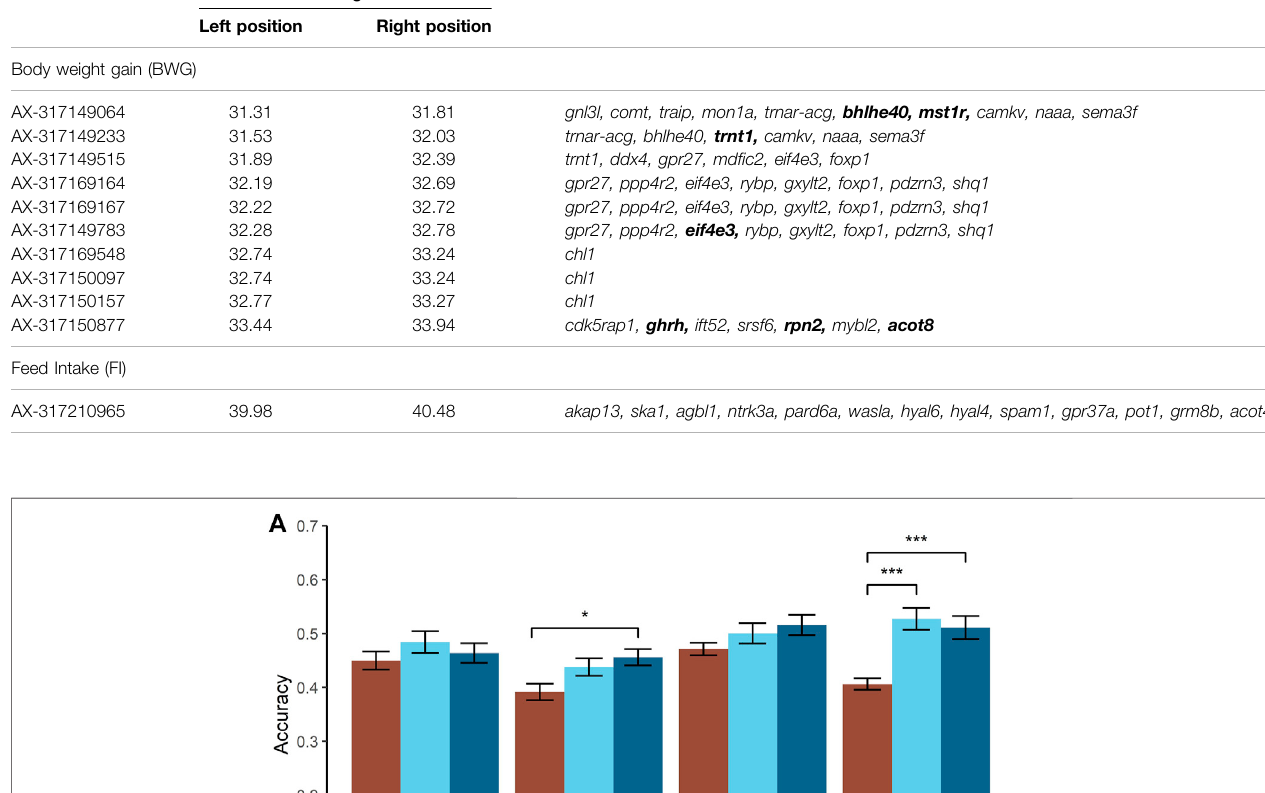
TABLE 5 | Genes fl anking the signi fi cant SNPs associated with feed-ef fi ciency related traits in a Nile tilapia breeding population. Bold genes represent genes with potential impact on feed-ef fi ciency related traits. SNP